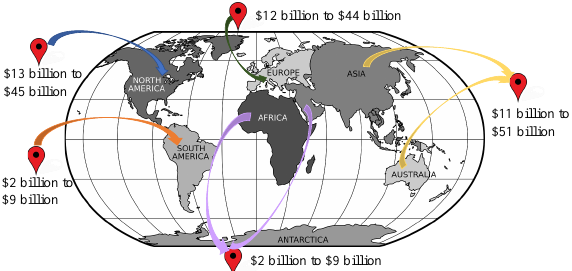
Figure 4. Global Internet of Medical Things (IoMT) growth